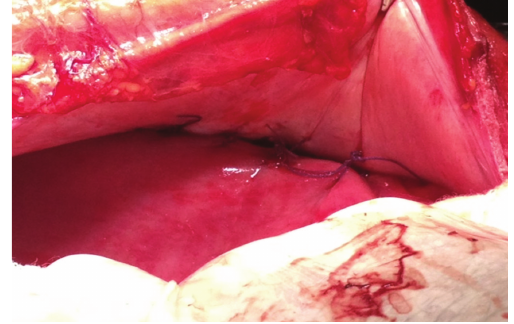
Figure 7: Anterior